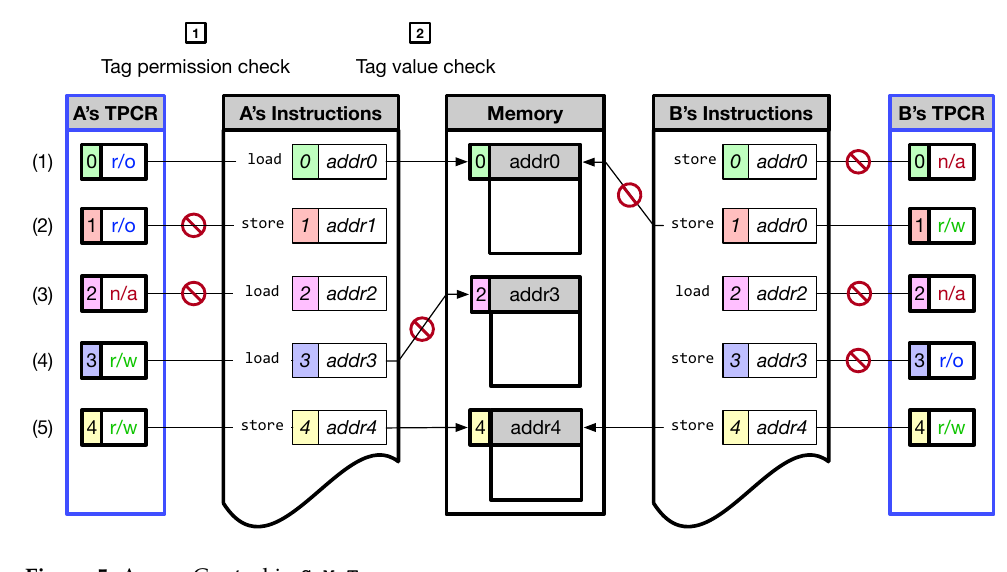
Figure 5. Access Control in CoMeT